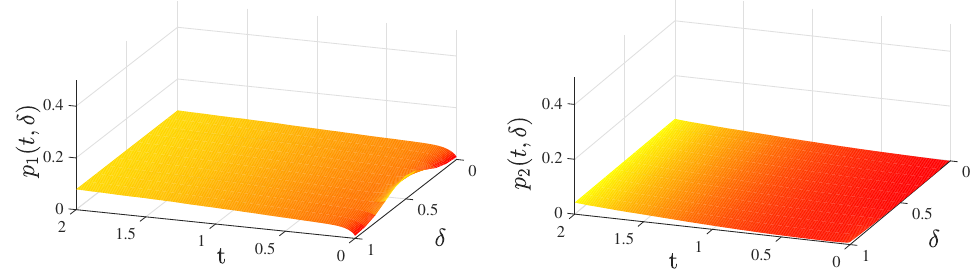
Figure 1. The state trajectories of System (19) without